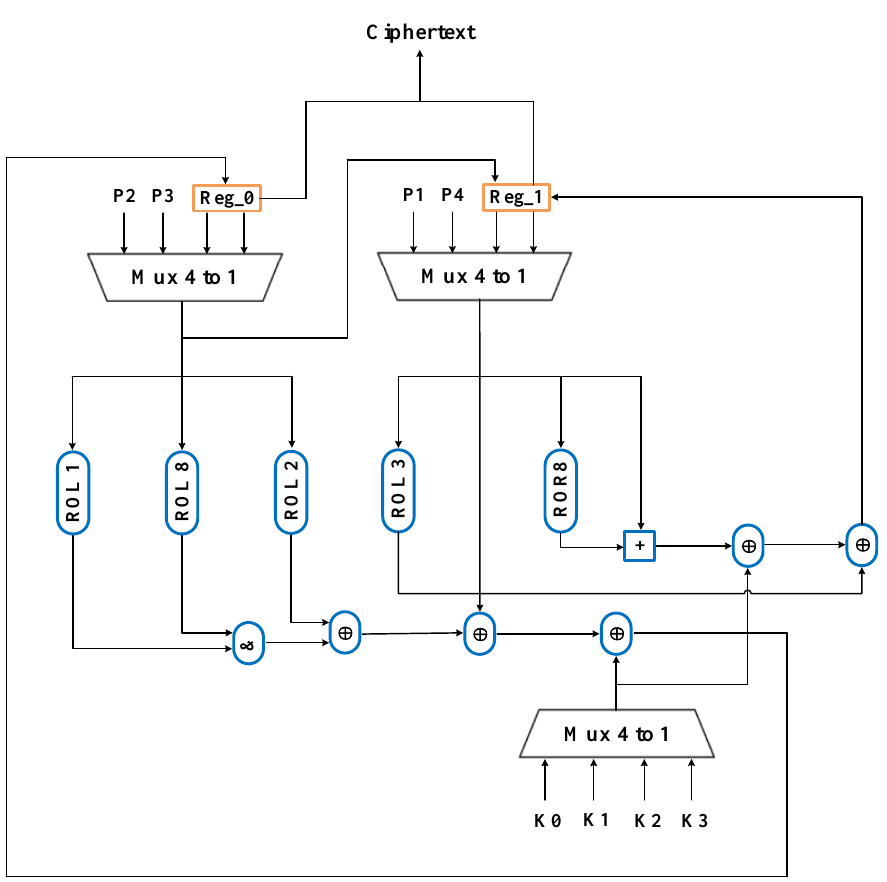
Figure 10. The serial architecture of the GFRX